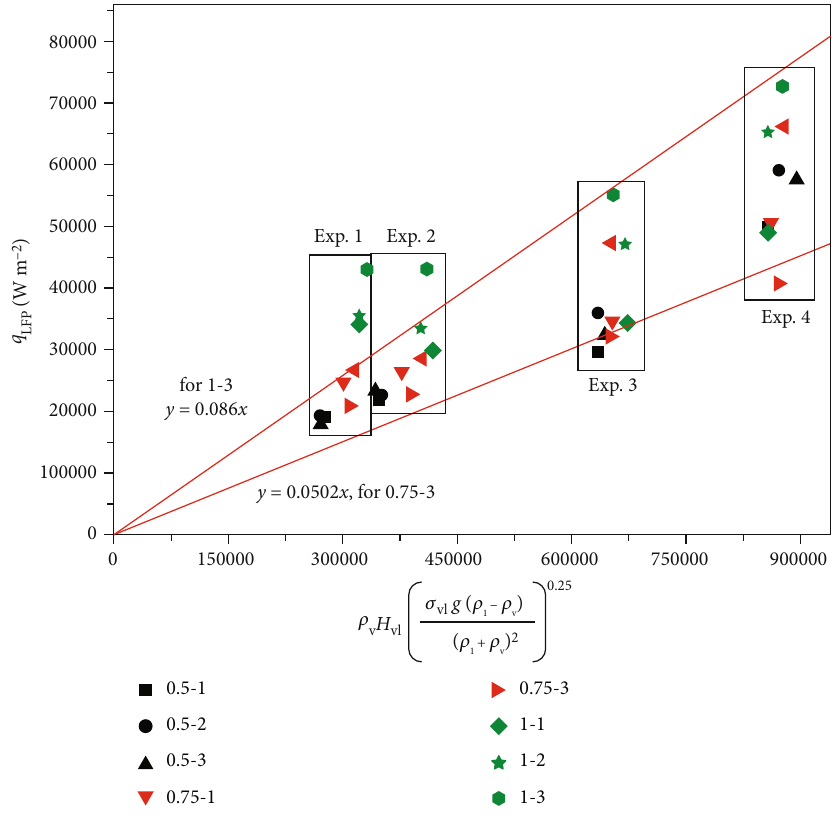
Figure 14: Correlation on q